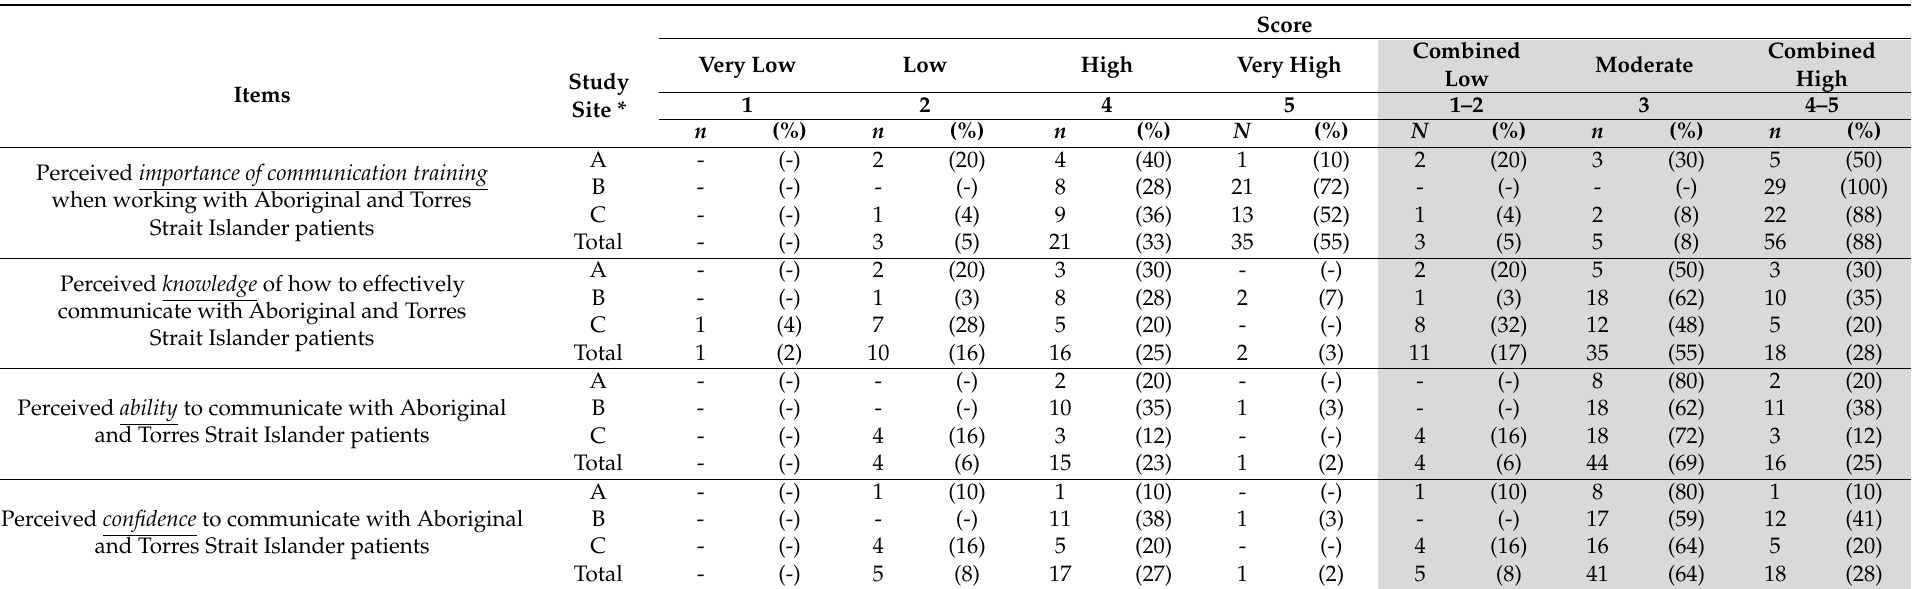
Table 2. Clinicians’ ( N = 64) rating of the importance of training, knowledge, ability and confidence to communicate with Indigenous Australian